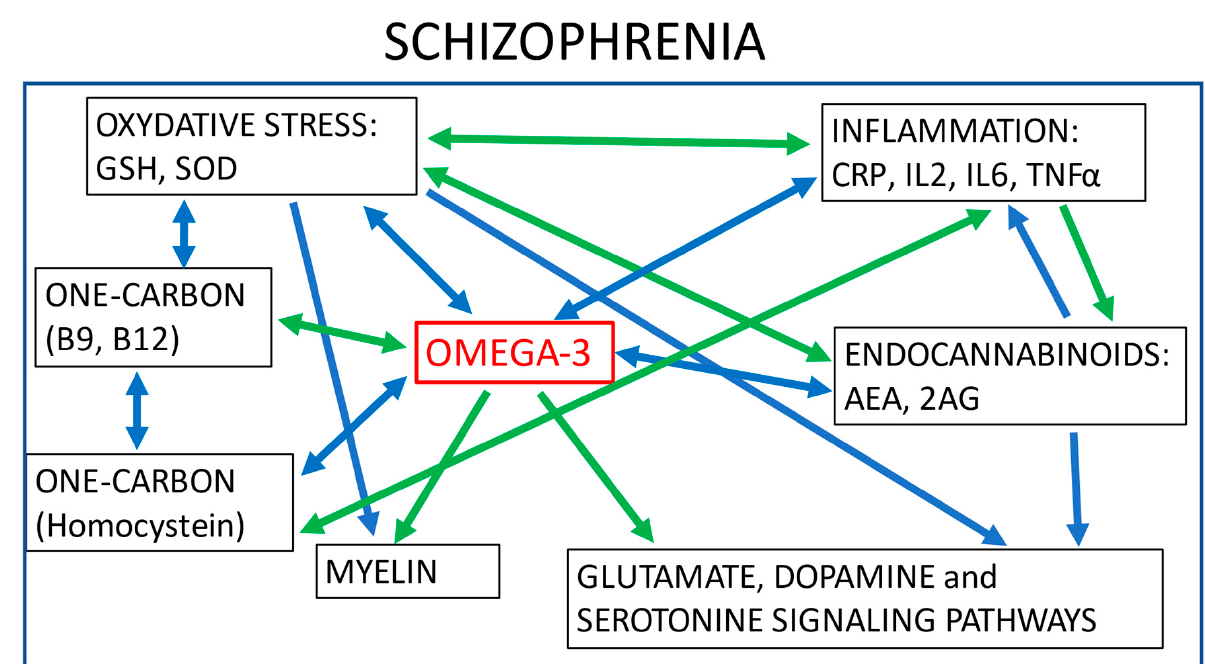
Figure 2. Interactions between different biological pathways involved in schizophrenia. Green arrows: positive correlations; blue arrows: negative correlations; GSH: glutathione; SOD: superoxide dismutase; CRP: C reactive protein; IL 2 : Interleukin 2; IL6: Interleukin 6; TNF α : Tumor Necrosis Factor; AEA: anandamide; 2AG: 2-arachidonoyl-sn-glycerol.